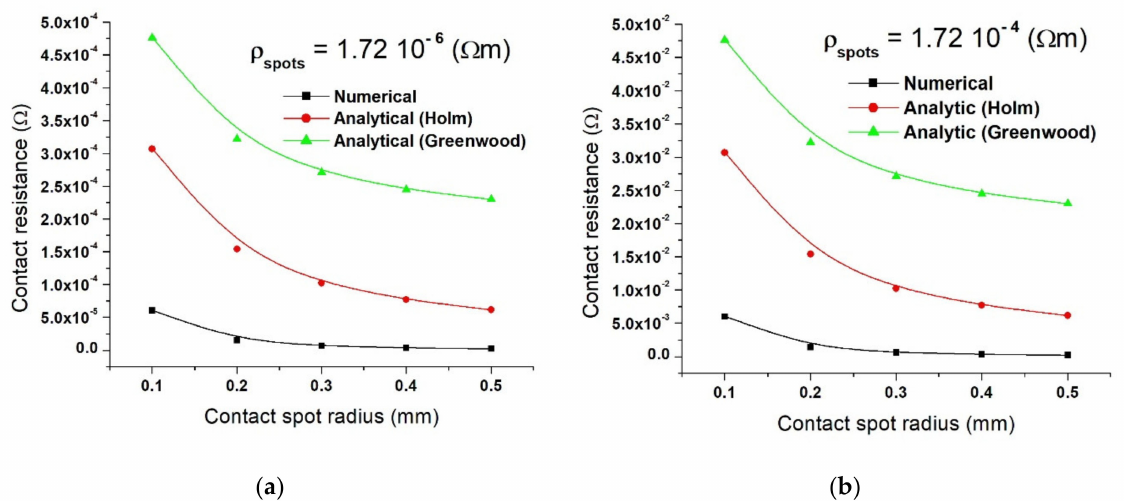
Figure 12. Contact resistance showing values for Holm and Greenwood (analytical) and numerical analysis calculated for ρ Cu = 1.72 · 10 − 8 Ω · m with ( a ) ρ Cs = 1.72 · 10 − 6 Ω · m and ( b ) ρ Cs = 1.72 · 10 − 4 Ω ·